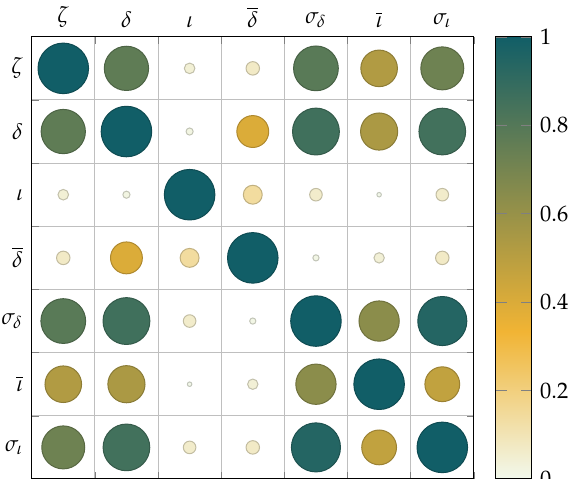
Figure 7. Summary of correlation of all metrics with congestion for all the scenarios analyzed, for fixed distance and data rates of 30 m and 30 Mbps . ζ is used for the congestion metric